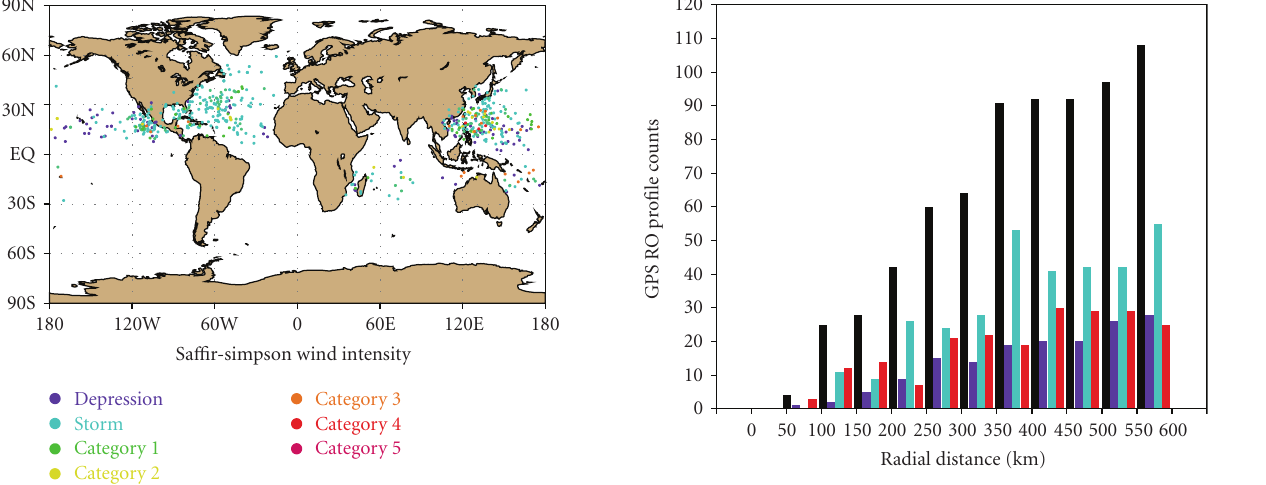
Figure 1: GPS RO profiles located within a 600 km radius and ± 180 temporal windows of the HBTRA TC positions for each Sa ffi r- Simpson intensity classification. 741 observations are collected during the 1995–2006 era within the North-Atlantic, Eastern Pacific, Western Pacific, Southern Indian, and Southern Pacific ocean basins while the respective GPS RO missions are active.